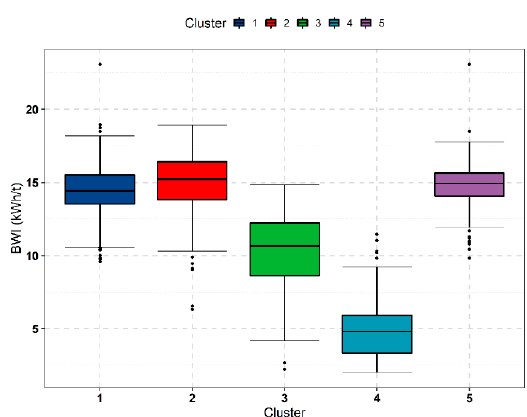
Figure 12. Bond ball mill work index (BWI) boxplots for each principal component analysis (PCA) cluster.